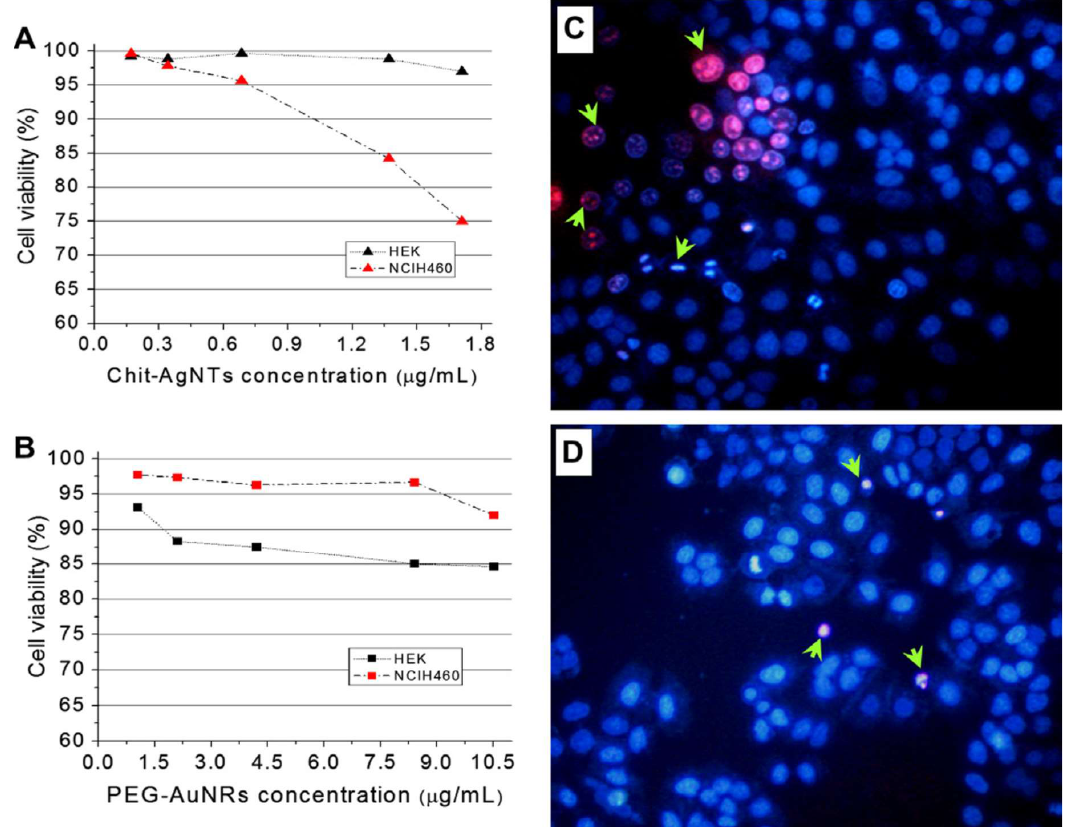
Figure 5. Demonstrates stabilizing feature of CS polymer during formation of CS capped silver nanotriangles. The CS-AgNTs are shown to exhibit better biocompatibility compared to PEG stabilized AuNRs. The figure shows ( A , B ) the cytotoxicity profiles of CS-stabilized AgNTs and PEG-AuNRs respectively towards HEK (black symbols) and NCI-H460 (red symbols) cells. NCI-H460 cells double-stained with Hoechst-viability and Propidium Iodide-mortality indicators the presence of ( C ) CS-AgNTs and ( D ) PEG-AuNRs. The arrows indicate condensed and fragmented nuclei typical of apoptotic cells. Reprinted with permission from Cancer Lett. 2011 , 311 , 131–140, Copyright 2011, Elsevier Ireland Ltd. [115].